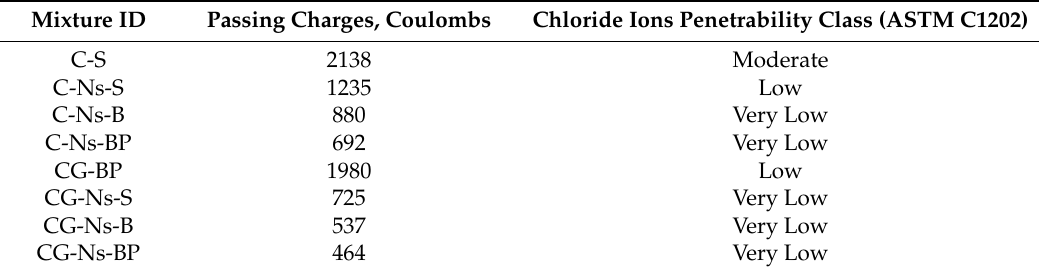
Table 6. The PERMIT ion migration test